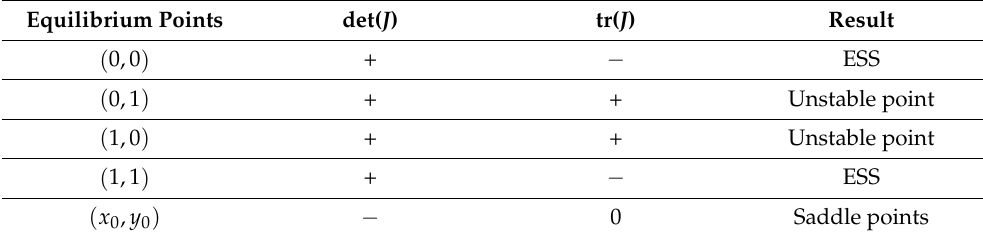
Table 3. Local stability analyses of